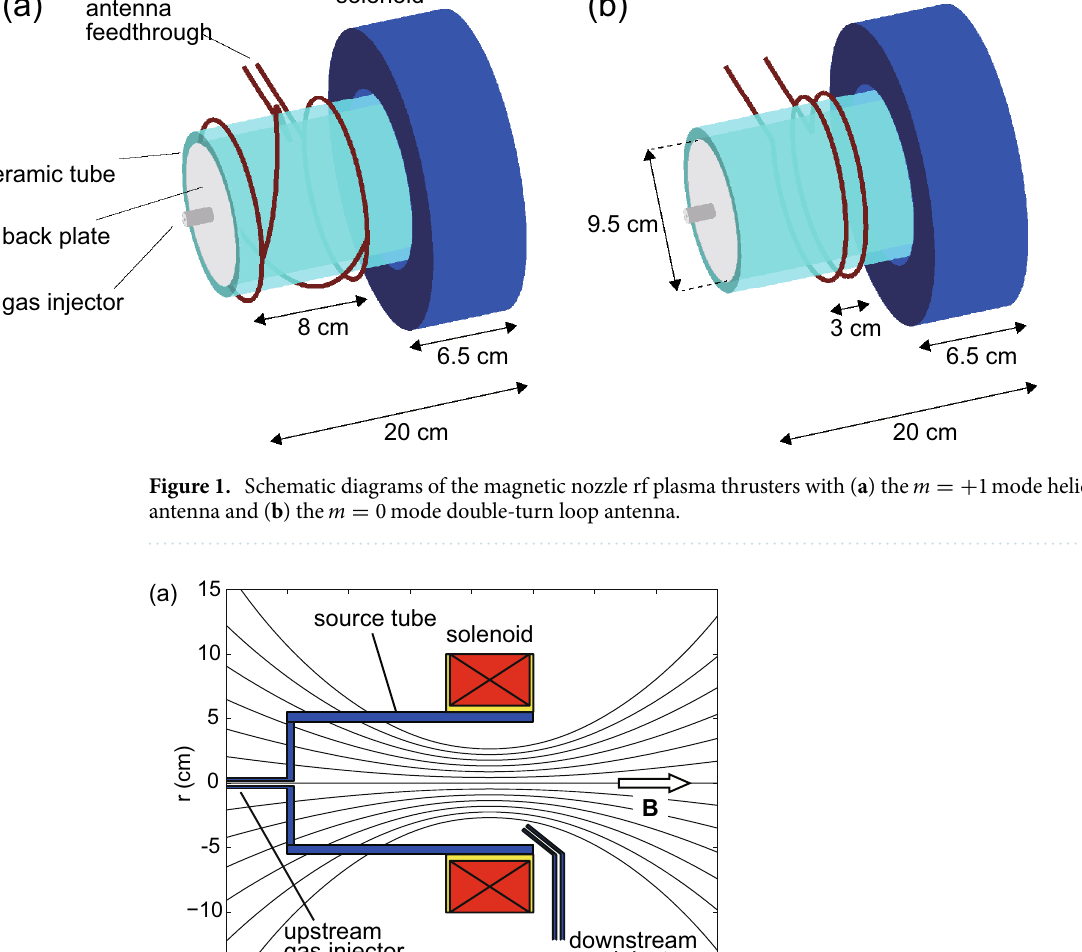
Figure 2. ( a ) Schematic diagrams of the thruster structure consisting of the insulator source tube, the insulator back plate, the upstream and downstream gas injectors, and the solenoid, together with the calculated magnetic field lines (solid lines). A block arrow shows the direction of the magnetic field. ( b ) Calculated magnetic field 1 A. The magnetic field is convergent near the thruster strength on the z axis for the solenoid current of I B = exit and expanding downstream of the source. Only the field strength can be changed by the solenoid current I B while maintaining the structure of the field